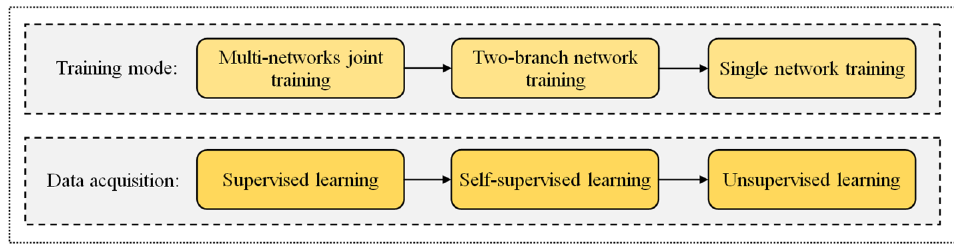
Figure 6. Development of end-to-end matching with learning-based methods.